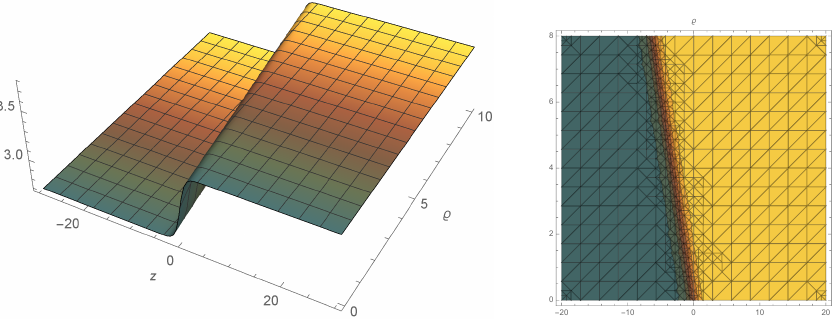
Figure 6. Three-dimensional (3D) and contour plots of the dark soliton solution of Equation